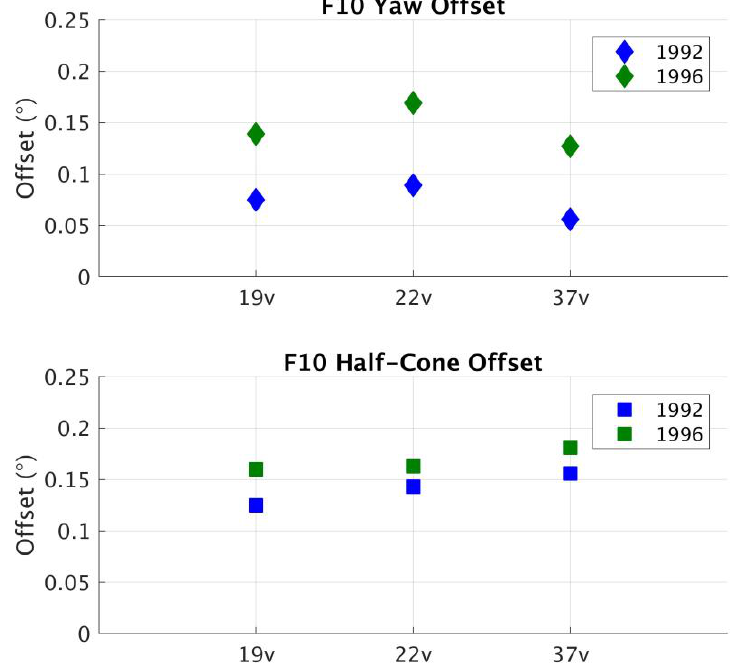
Figure 4. Derived yaw ( Top ) and half-cone ( Bottom ) angle offsets for F10 19v, 22v, and 37v channels using observations from 1992 and 1996. The three channels and two years are averaged to give the final yaw and half-cone angle